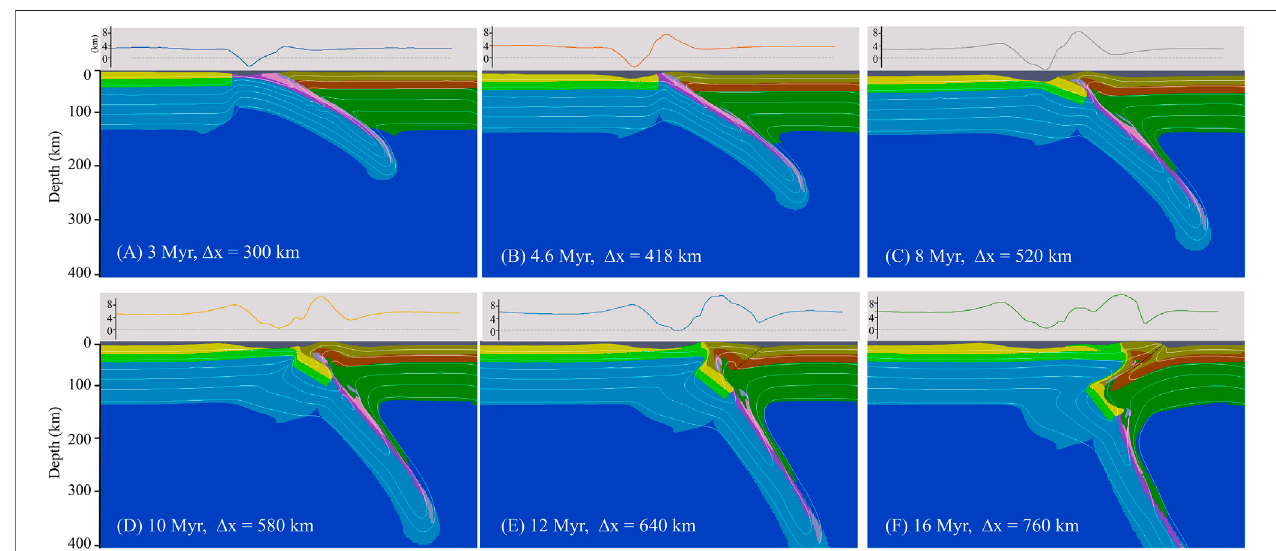
FIGURE 5 | Evolution of polarity reversed mode. Panels above each snapshot with gray shading show the corresponding topography. Δ x is the amount of convergence. Different colors in (A – F) denote different lithologies (same as Figure 2